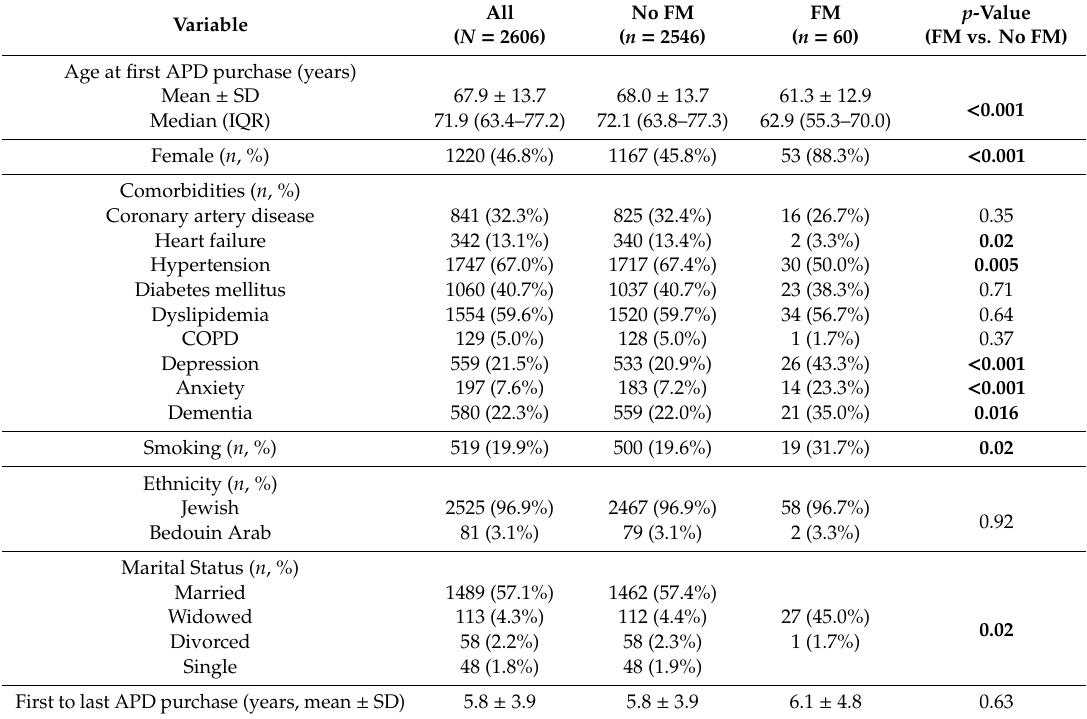
Table 1. Baseline characteristics of Parkinson’s disease patients by diagnosis of fibromyalgia.